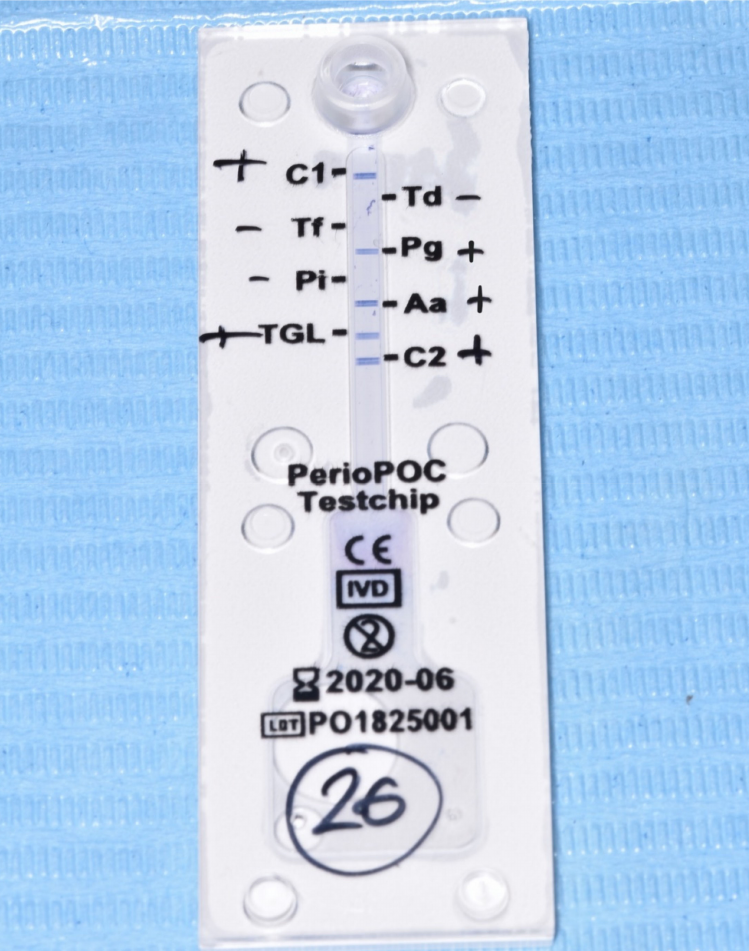
Figure 2. Periodontopathogen determination test